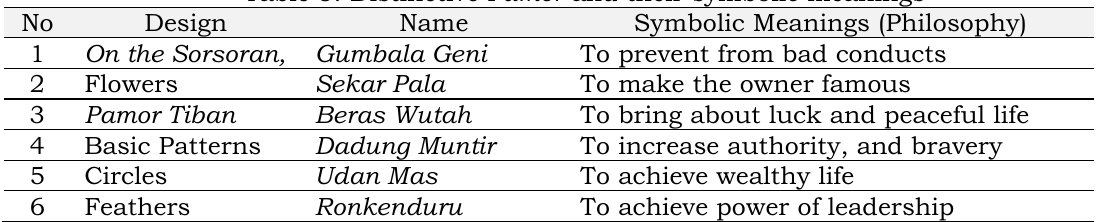
Table 3. Distinctive Pamor and their symbolic